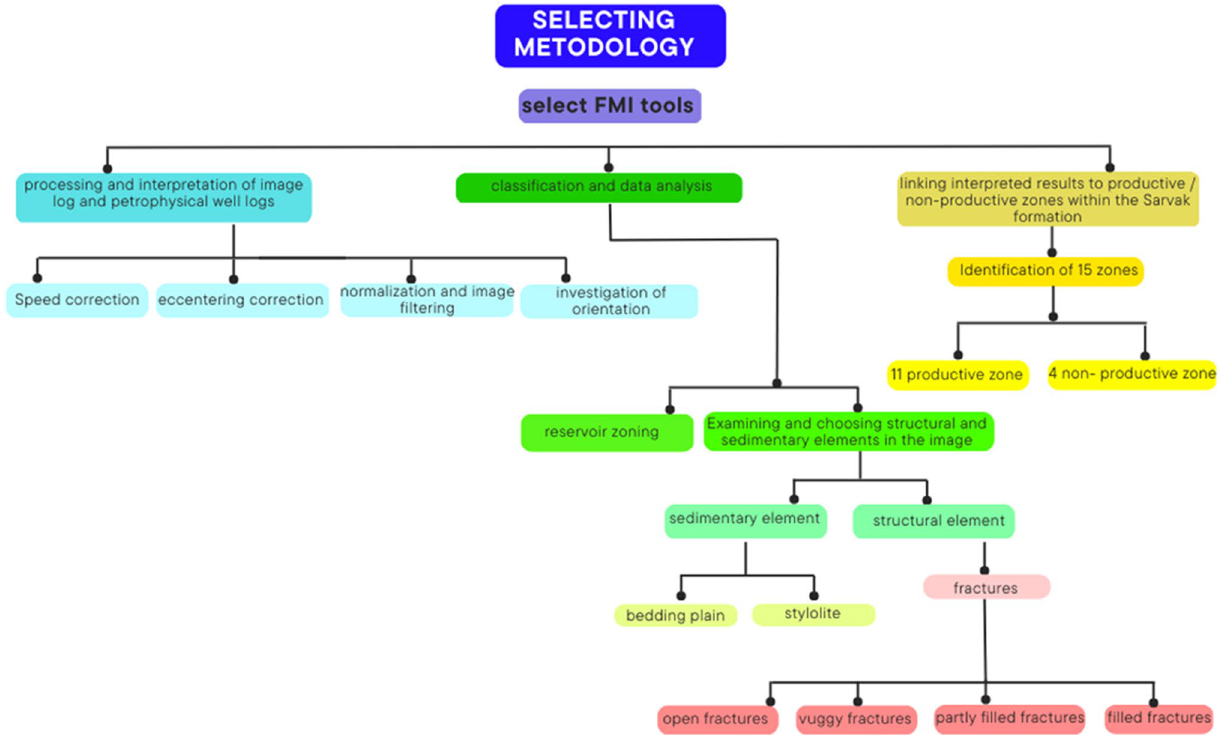
Fig. 3 Flowchart of methodology used in this study for fracture